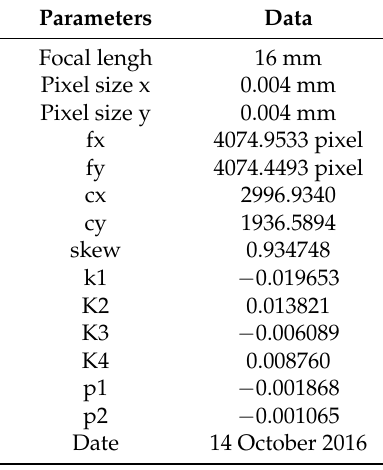
Table 1. Calibration parameters of the